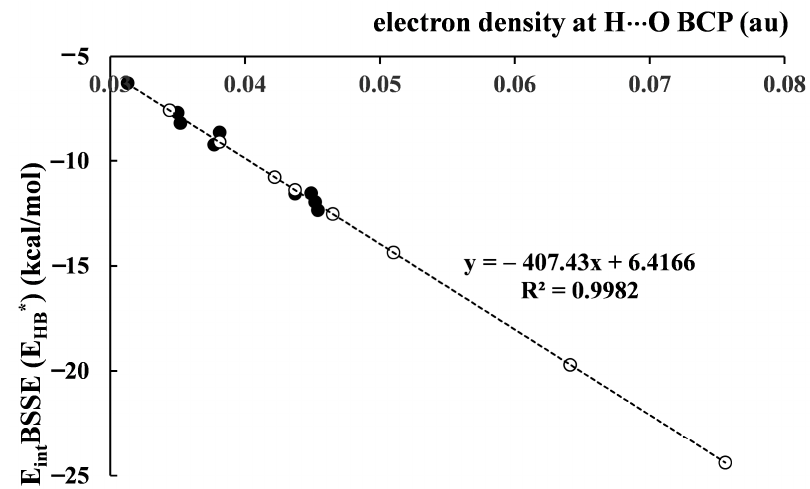
Figure 5. The relationship between the electron density at H . . . O BCP (au) and the E int BSSE (E HB* ) energy (kcal/mol); full circles correspond to intermolecular hydrogen bonds while open circles correspond to intramolecular hydrogen bonds; the energies for former interactions are E int BSSE (Table 5), while intramolecular interaction energies are E HB* values (Table 7).